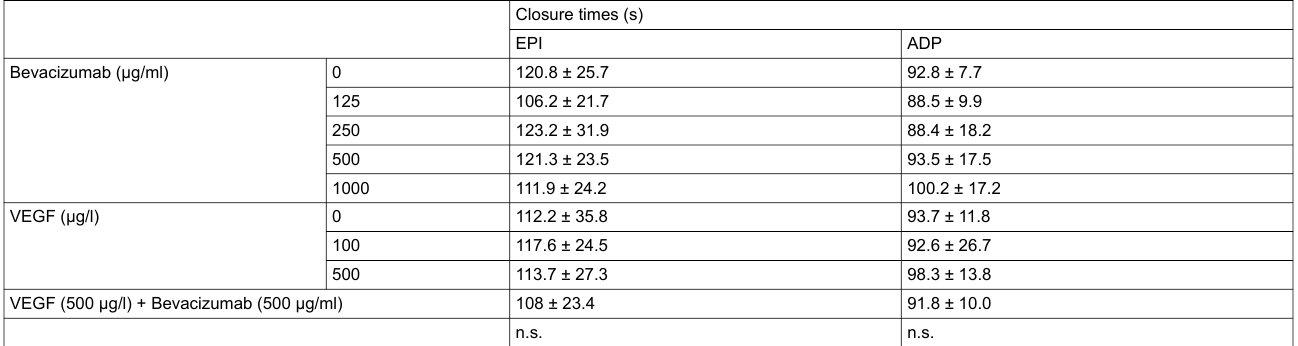
Table 1: PFA-100® closure times using either collagen/epinephrine (EPI) or collagen/adenosine diphosphate (ADP) as a platelet activator in in vitro experiments with bevacizumab, VEGF, or a combination thereof (mean ± SD, n = 10; n.s. = not